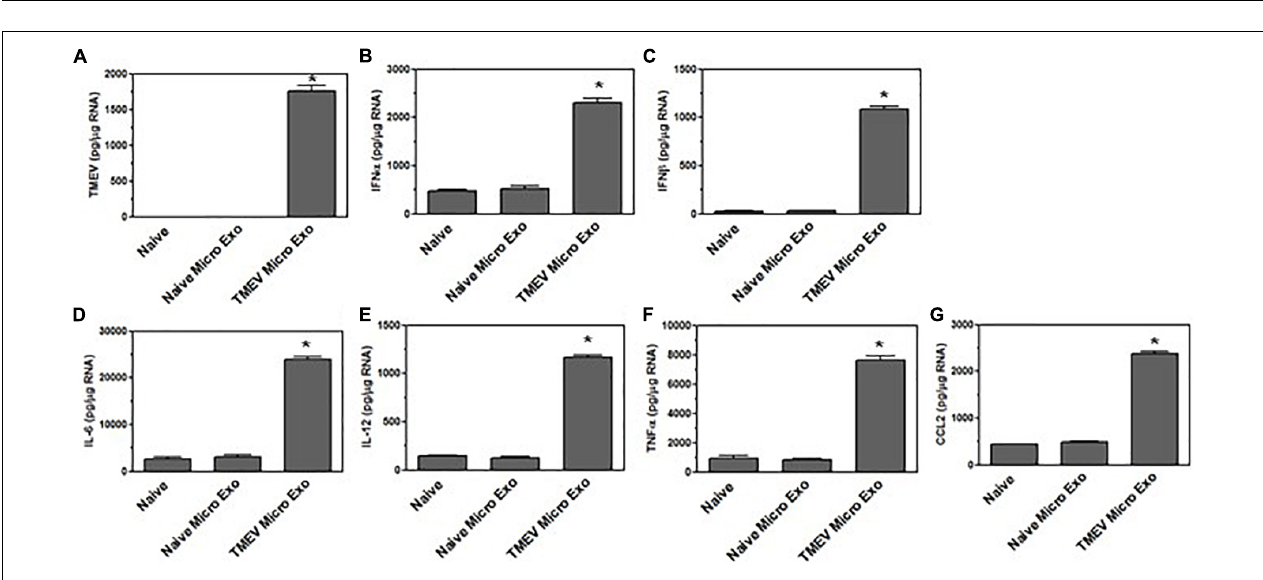
viral RNA to neurons and activated the neurons to express type I interferons, IFN α and IFN β , cytokines, IL-6, IL-12, and TNF α , and chemokines, CCL2, compared to exosomes from uninfected microglia. These results show that exosomes secreted by TMEV-infected microglia activate expression of innate immune cytokines and chemokines in uninfected bystander CNS resident cells, astrocytes and